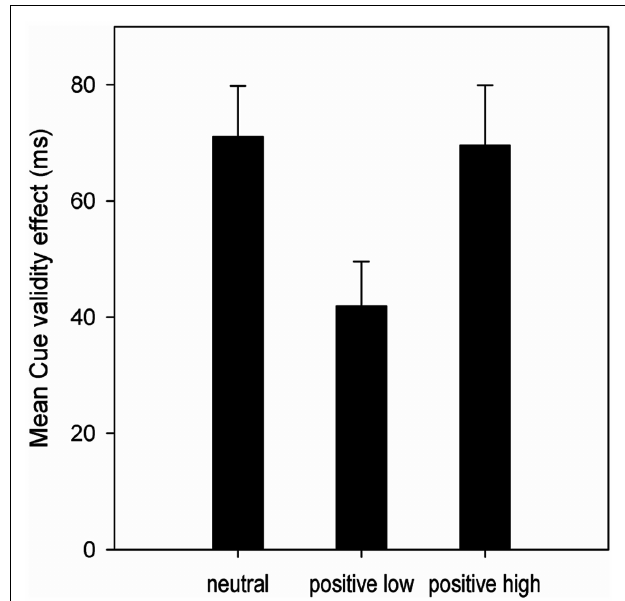
FIGURE 2 | Mean Cue validity effects (in ms) in the spatial response cueing task of Experiment 2 as a function ofAffect group. Error bars represent 1 standard error of the